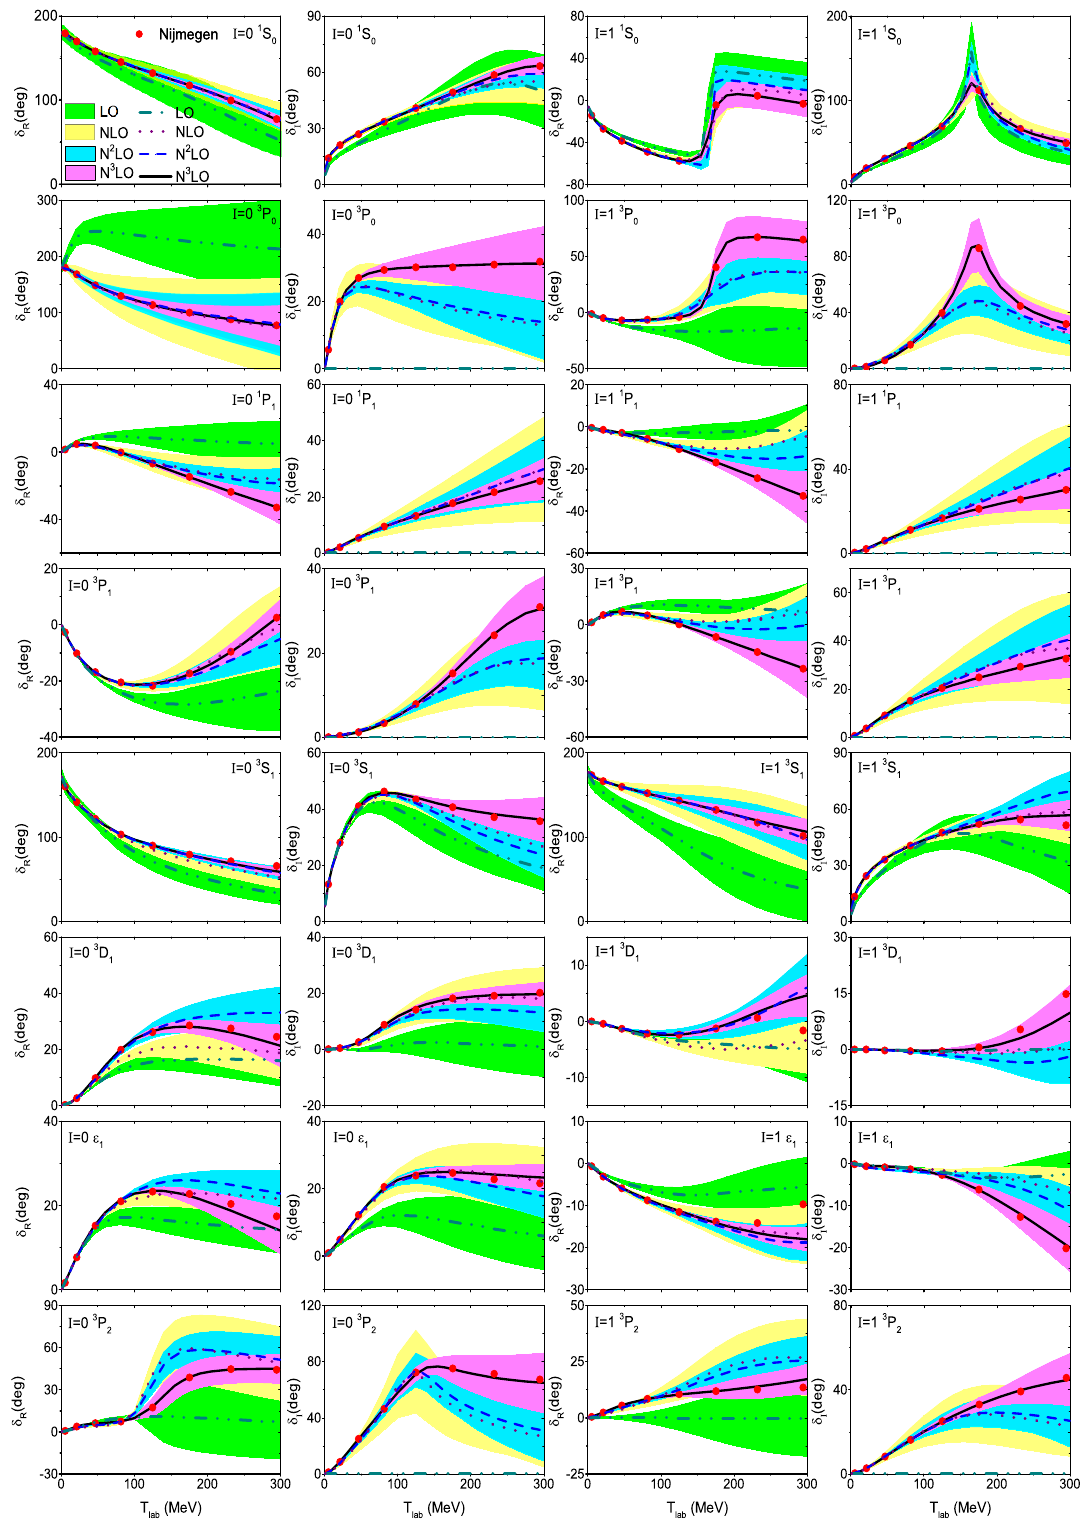
Figure 6 . Real and imaginary parts of (cid:22) NN phase shifts for the potential with cuto(cid:11) R = 0 : 9 fm. Notations are described in the text. The (cid:12)lled circles represent the solution of the (cid:22) pp PWA [32].